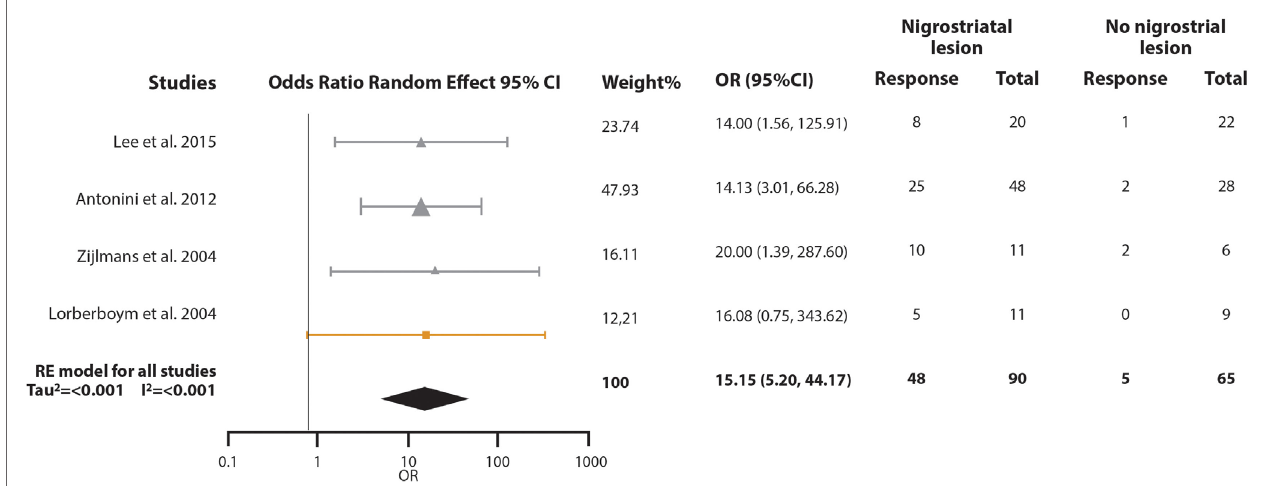
FigURe 4 | Pooled odds ratio (OR) and 95% confidence interval (CI) for the probability of vascular parkinsonism (VP) subjects responsiveness to levodopa with nigrostriatal lesion compared with VP subjects without nigrostriatal lesion. Circles represent studies with the “Other” diagnostic criteria, squares represent studies with the “Winikates’” diagnostic criteria, and triangles represent “Ziljmans’ ” diagnostic criteria. Size of the geometrical figures is proportional to their respective relative weight. RE, random effect.